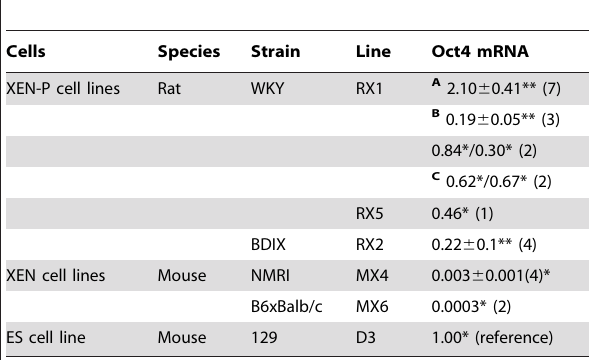
Table 1. Quantitative RT-PCR for Oct4 in whole-culture (*) and micro- (**) XEN-P cell line